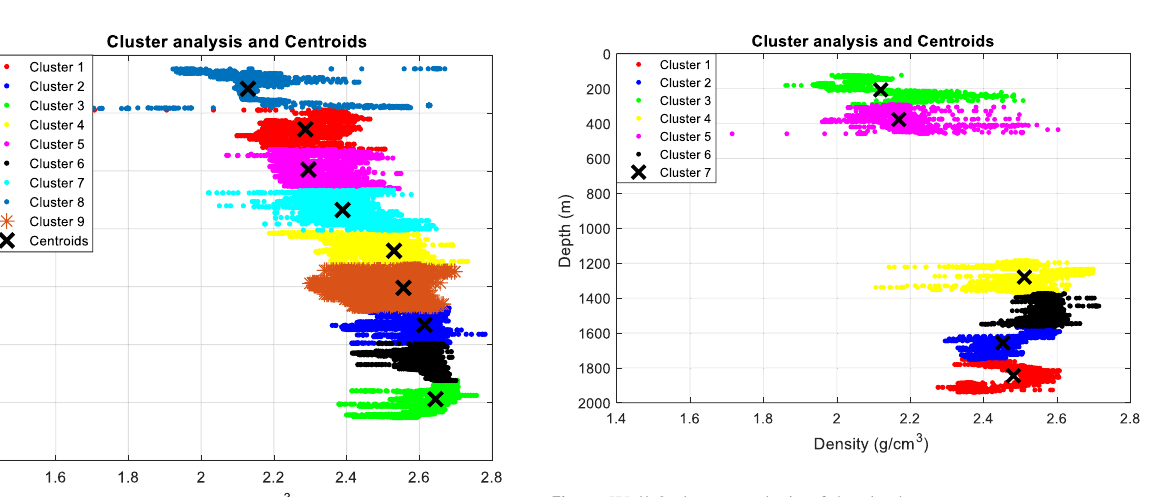
Fig. 3 Well-1 cluster analysis of P-wave Velocity